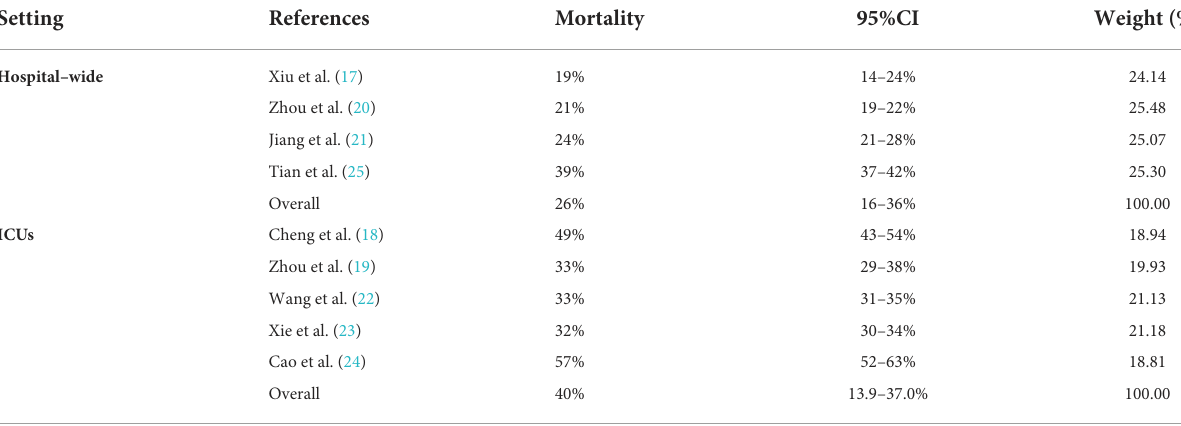
TABLE 6 The mortality of sepsis in hospital–wide and ICUs in